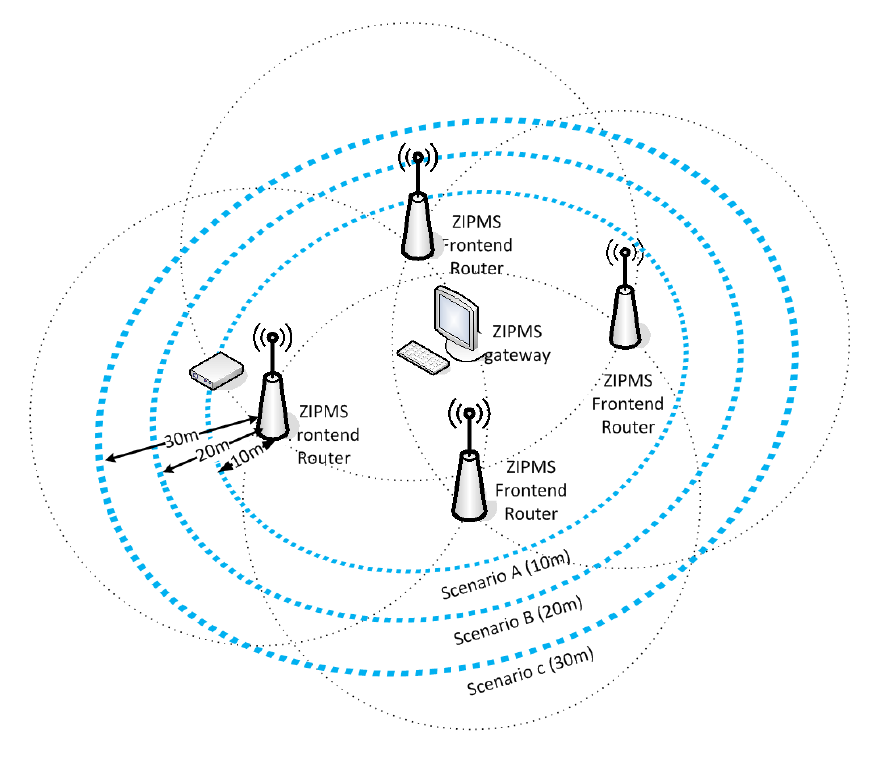
Figure 11. Experimental setup of reliability